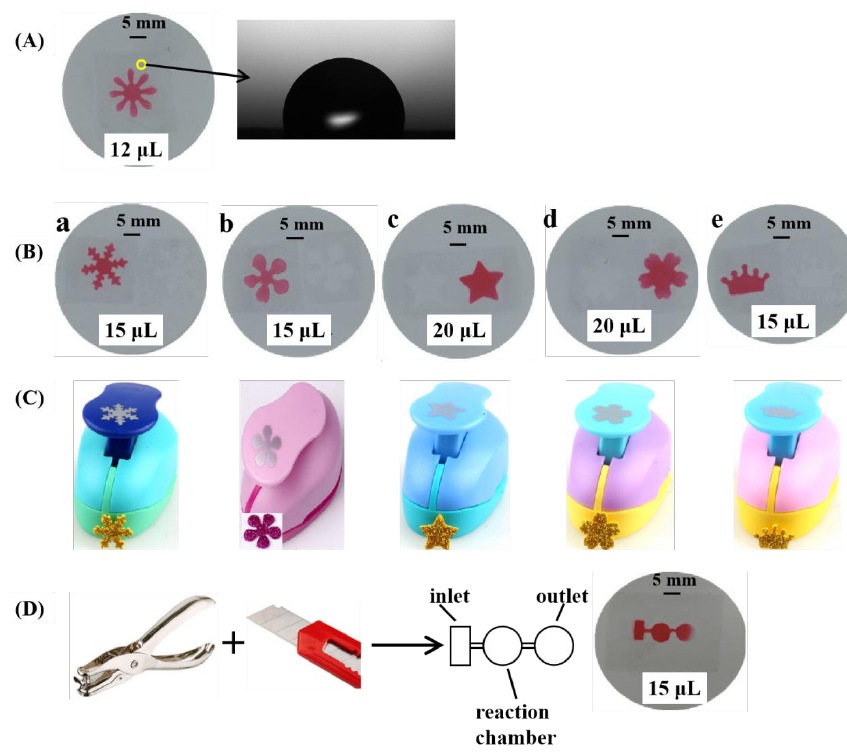
Figure 3. ( A ) Photograph of water droplets on the surface of prepared µ PADs with the chrysanthemum design. ( B ) Single-layered microfluidic chip with simple designs. ( C ) The craft punch with di ff erent shapes: snowflake, flowers with five petals, pentagram, cherry blossom, and crown. ( D ) Single-layered µ PAD with a complicated design after adding 15 µ L of red colored food